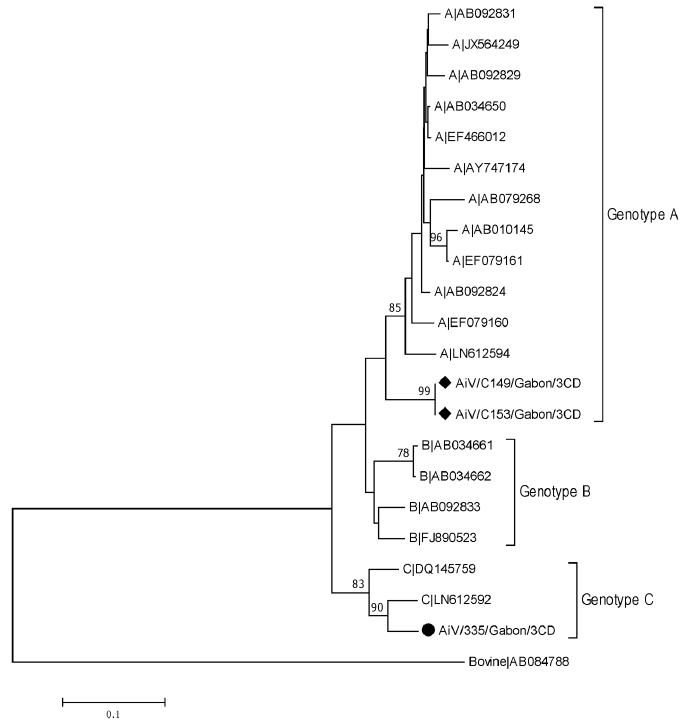
Figure 6. Phylogenetic tree of a 459 bp alignment of 3CD region of aichivirus (AiV) strains from Gabon and AiV reference sequences (accession nos. are indicated). Samples from symptomatic patients are marked with a dot and samples from asymptomatic patients with a rhombus. The tree was constructed using the neighbor-joining method with the bootstrap test (1000 replicates) and Tamura 3-parameter method available in MEGA7. Bootstraps value above 70 are shown. The bar indicates the variation scale.